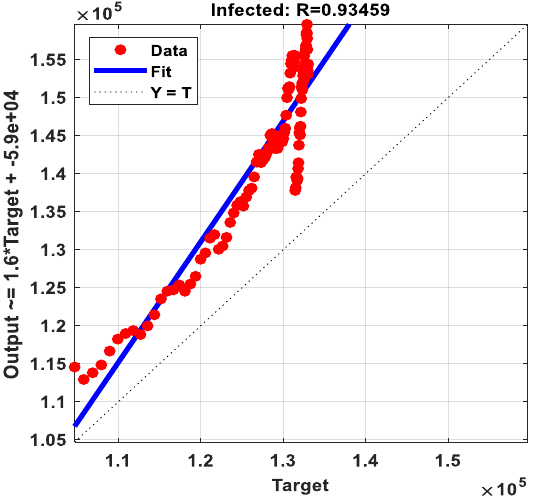
( a ) The correlations coefficients and the linear regression equations between the observed infected values and the target values (PPA-MMLPNN model values) for Mexico. Figure 10. Cont